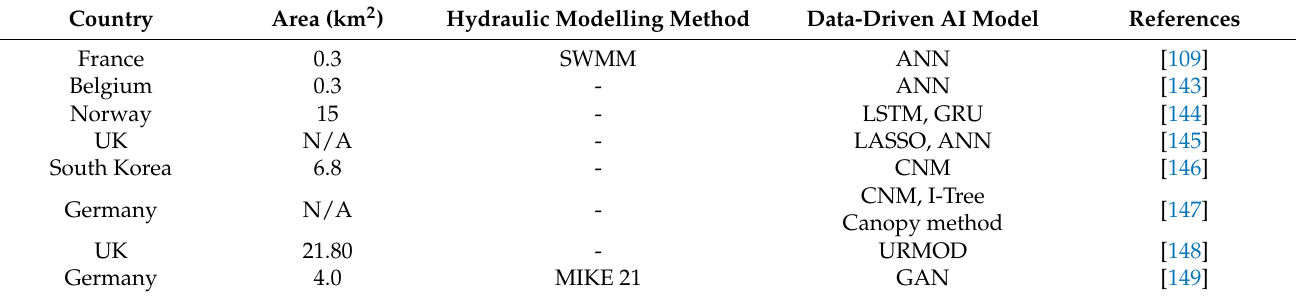
Table 2. Recent research on data-driven AI models for real-time urban flood forecasting